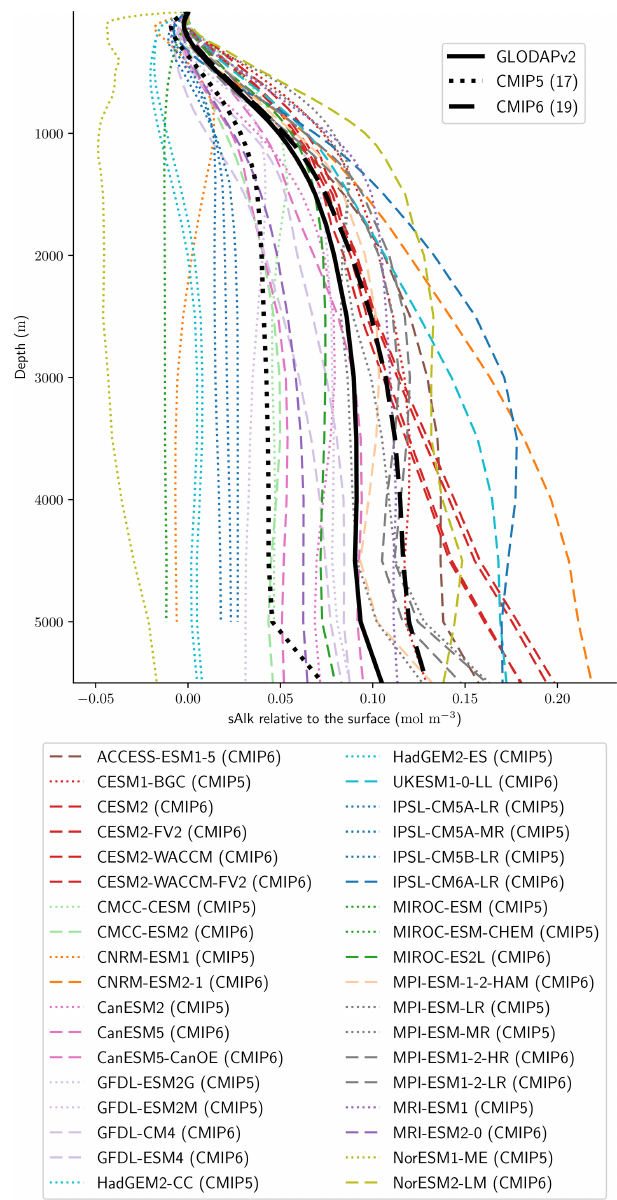
Figure 5. Global open-ocean mean sAlk vertical profile anomalies relative to surface values. The ESMs considered in this study are shown in addition to the CMIP5 (dotted) and CMIP6 (dashed) en- semble means and GLODAPv2 (solid)